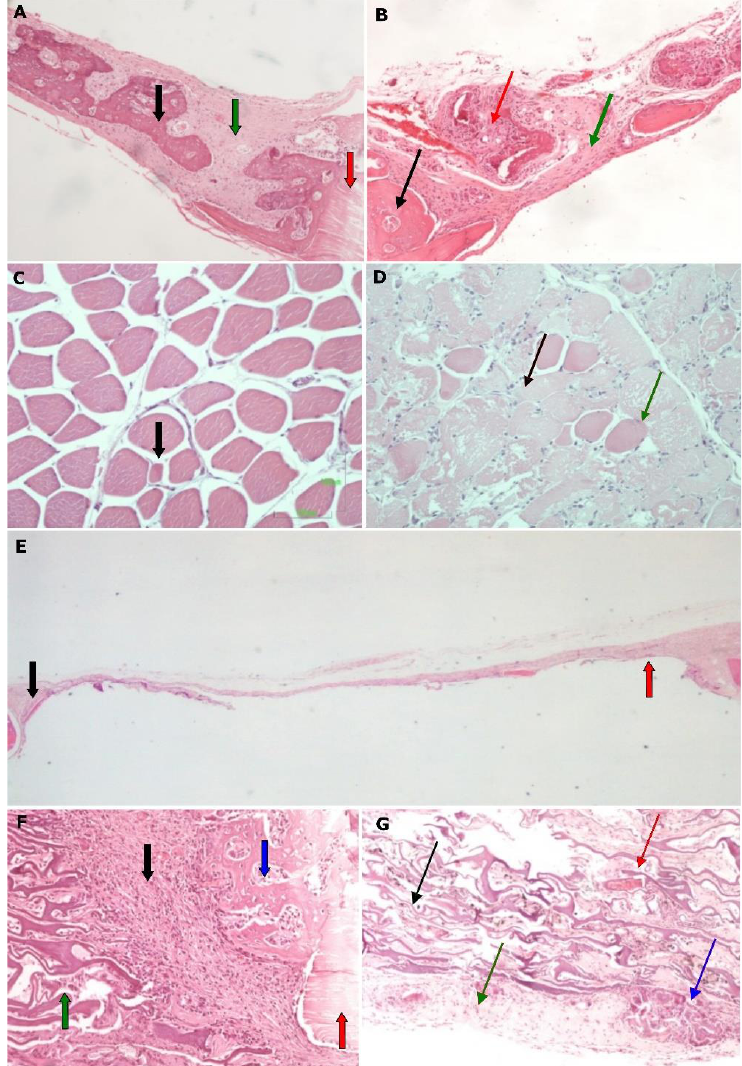
Figure 6. Histological micrographs of groups STS and STL. ( A ) Group STS1, magnification 100 × : bone tissue with abundant new osseous tissue formation (black arrow) in contact with the margin of the defect (red arrow) and fibrous connective tissue growth (green arrow); ( B ) Group STS2, magnifi- cation 100 × : the new tissue (black arrow) begins to degrade (red arrow) and is replaced by fibrous connective tissue (green arrow); ( C ) Group STS1, magnification 100 × : microscopic image of quadri- ceps muscle with limited atrophic muscle fibers (black arrow); ( D ) Group STS2, magnification 100 × : microscopic image of quadriceps with almost complete destruction of muscle fibers (black arrow), replaced by fibrous connective tissue and few remaining muscle fibers (green arrow); ( E ) Group STL3, magnification 20 × : complete degradation of membrane and this has been replaced by thin fibrous connective tissue of limited thickness (red arrow). Minimal newly formed osseous tissue is observed at the margin of the defect (black arrow); ( F ) Group STL1, magnification 200 × : at the margins of the defect (red arrow), the formation of new osseous tissue begins (blue arrow), the membrane is slightly stretched without significant signs of degradation (green arrow), while inflammatory infiltrate can be seen (black arrow); ( G ) Group STL2, magnification 200 × : at 4 weeks, moderate degradation of the membrane (black arrow) is observed, marked by vessels (red arrow) and by its gradual replacement by fibrous connective tissue (green arrow). Additionally, material degradation is observed, with multinucleated foreign body-type giant cells being present (blue